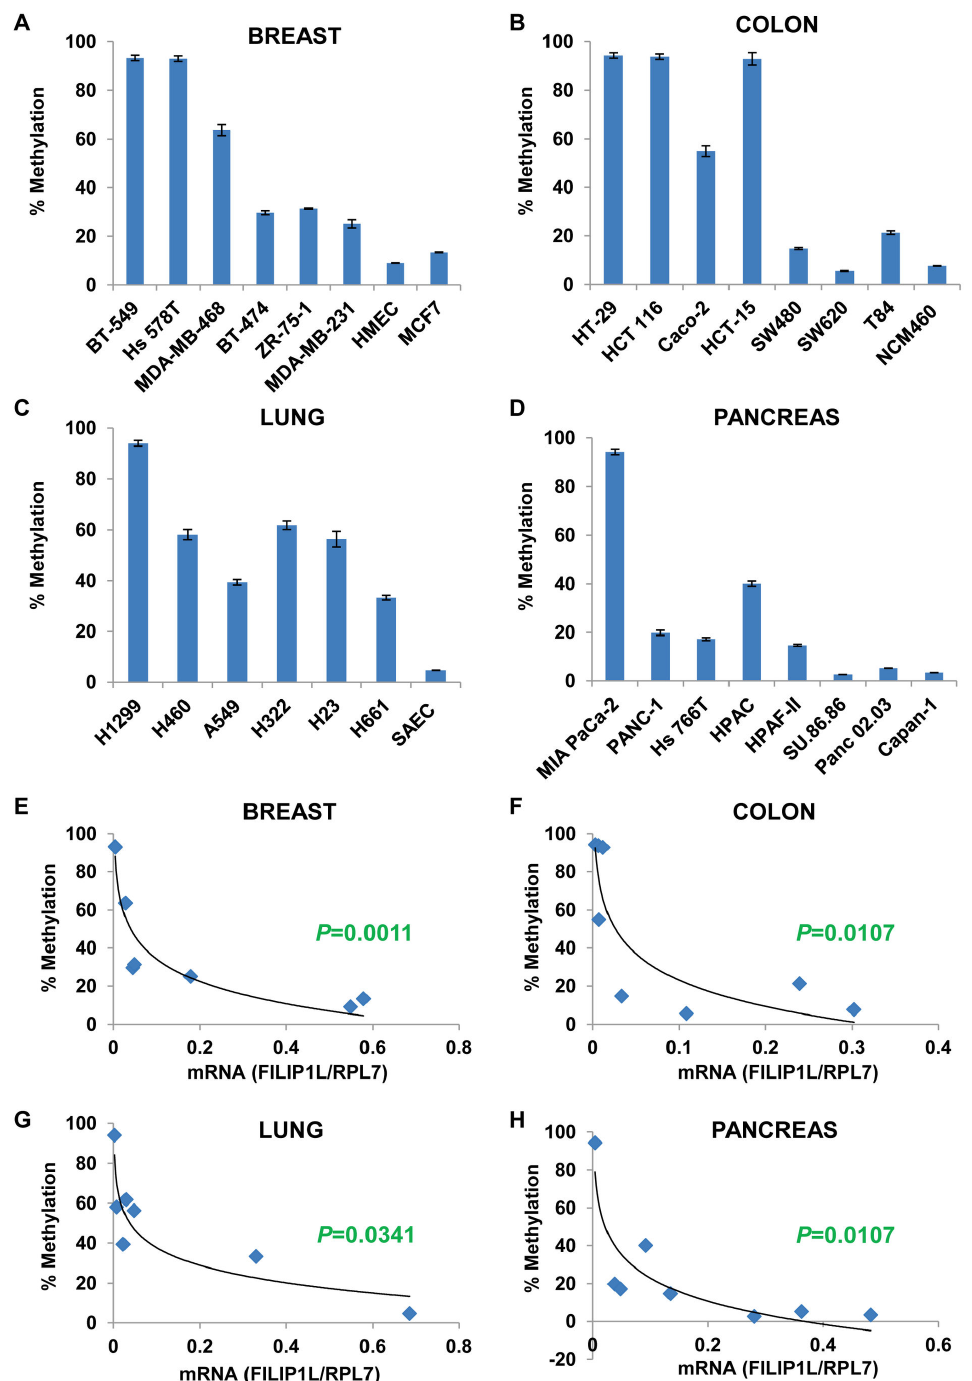
Figure 3. Inverse correlation of FILIP1L expression with FILIP1L promoter methylation in various human cancer cell lines. A - D , DNA methylation status of the CpG island in the FILIP1L promoter from the same cell lines utilized in Figure 1 was analyzed by Sequenom® EpiTYPER Mass Array. Mass Array results are shown as the average overall methylation for the analyzed 21 CG sites out of total 59 CG sites in the CpG island of the FILIP1L promoter. Error bars indicate SEM ( n = 3). E-H , A significant inverse correlation of the DNA methylation status of the CpG island in the FILIP1L promoter with FILIP1L mRNA expression (each P value was calculated by Spearman’s rank correlation method). y axis: percent methylation of the average overall methylation for all 21 CG sites shown in sections A-D was used. x axis: standardized FILIP1L mRNA expression shown in Figure 1 was used. doi: 10.1371/journal.pone.0082620.g003 PLOS ONE |